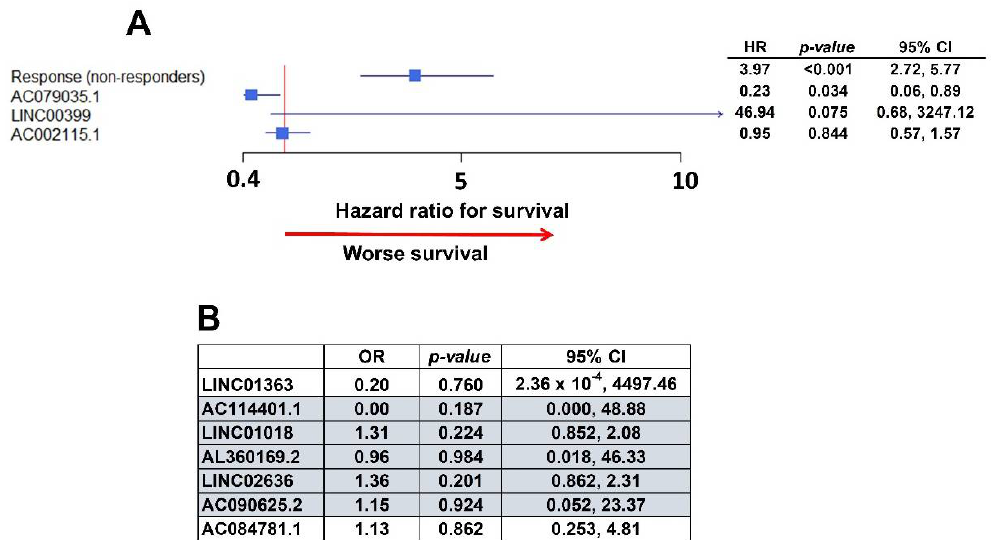
Figure 6. Validation within The Cancer Genome Atlas (TCGA) ovarian cancer dataset. ( A ) Forest plot with the multivariate analysis of survival in TCGA data. AC079035.1 and LINC00399 are associated with better and worse survival, respectively, as they were in the initial University of Iowa (UI) analysis. ( B ) Table with multivariate analysis of chemo-response in TCGA data. Highlighted lncRNAs had the same association with chemo-response as in the initial UI model: OR smaller than one is an association with worse chemo-response, greater than one represents better response to chemotherapy.